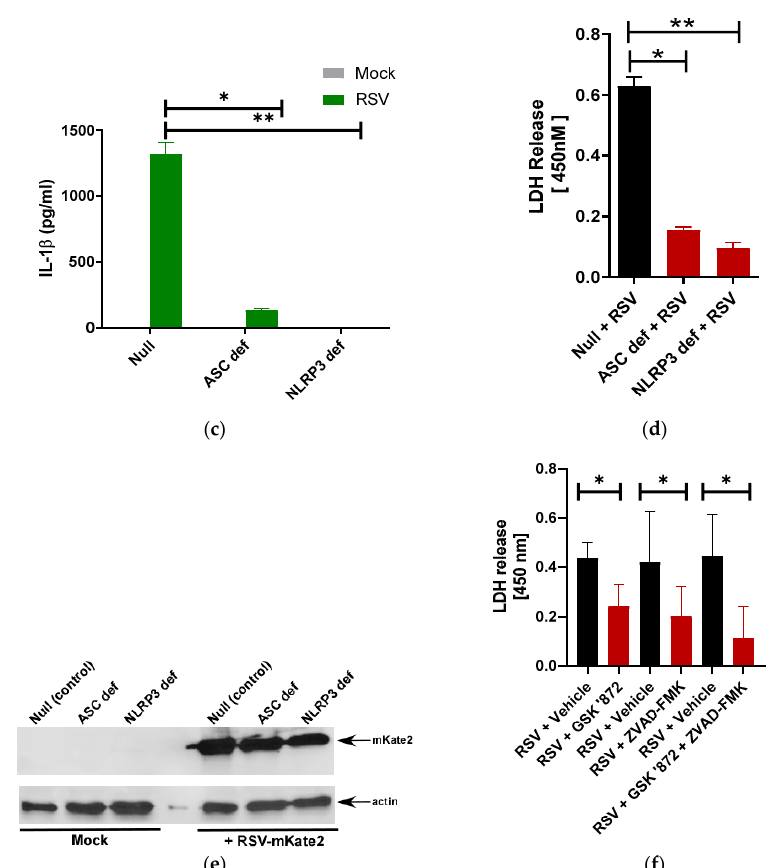
Figure 4. Caspase-1 and ASC-NLRP3 inflammasome is required for pyroptotic cell death of macrophages during RSV infection. ( a ) Human THP-1 macrophages were infected with RSV (MOI = 1) in the presence of either vehicle (DMSO) or caspase-1 inhibitor (caspase-1i) Ac-YVAD-CHO (20 µM and 40 µM). LDH release was measured (at OD of 450 nm) at 16 h post-infection infection ( n = 12 technical replicates from two independent experiments). * p ≤ 0.05 using a Student’s t -test. ( b ) Wild-type (null), ASC deficient (ASC def), and NLRP3 deficient (NLRP3 def) THP-1 macrophages were treated with LPS (100 ng/mL) for 4 h, followed by 30 min treatment with nigericin (15 µM). IL-1 β release was measured by ELISA ( n = 16 technical replicates from two independent experiments). * p and ** p ≤ 0.05 using a Student’s t -test. ( c ) Null, ASC def, and NLRP3 def THP-1 macrophages were infected with RSV (MOI = 1). At 16 h post-infection, IL-1 β release was measured by ELISA ( n = 16 technical replicates from two independent experiments). * p and ** p ≤ 0.05 using a Student’s t -test. ( d ) Null, ASC def, and NLRP3 def THP-1 macrophages were infected with RSV (MOI = 1). LDH release was measured (at OD of 450 nm) at 16 h post-infection infection (n = 16 technical replicates from two independent experiments). * p and ** p ≤ 0.05 using a Student’s t -test. ( e ) Null, ASC def, and NLRP3 def THP-1 macrophages were infected with RSV-mKate2 (MOI = 2) for 16 h. Equal levels of total protein from the cell lysates of Null, ASC def, and NLRP3 def cells were subjected to Western blotting with anti-RFP antibody. Western blot data shown is representative of three independent experiments with similar results. ( f ) Human THP-1 macrophages were infected with RSV (MOI = 1) the presence of DMSO (vehicle control), RIPK3-dependent necroptosis inhibitor GSK’872 (40 µM), Caspase-1 dependent pyroptosis inhibitor ZVAD-FMK (50 µM), or the combination of these inhibitors (GSK ‘872 + ZVAD-FMK). LDH release was measured (at OD of 450 nm) at 16 h post-infection ( n = 14 technical replicates from two independent experiments). * p ≤ 0.05 using a Student’s t -test.